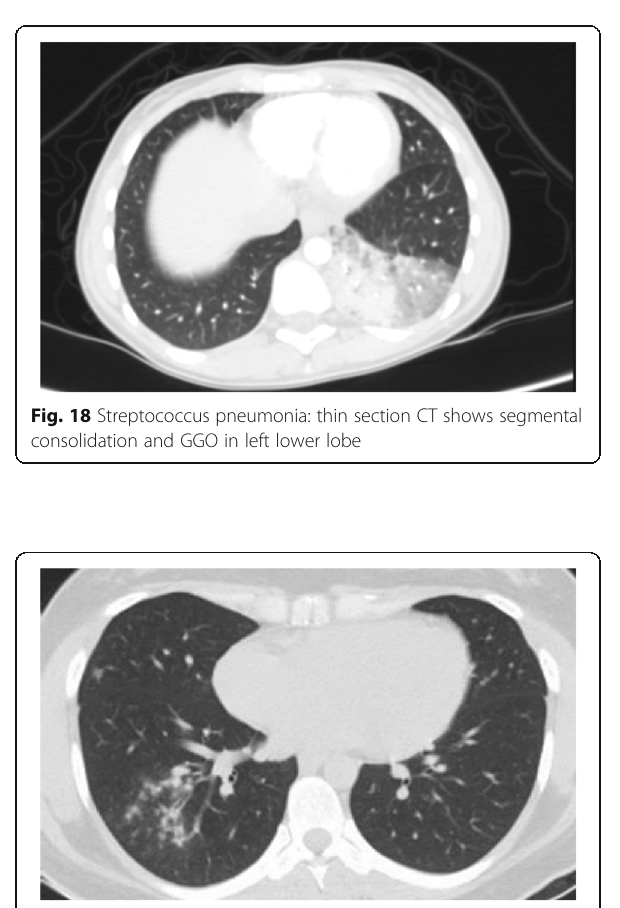
Fig. 19 COVID-19 pneumonia: thin section CT shows peribronchial thickening and centrilobular nodules with tree in bud appearance. despite atypical findings for COVID-19 pneumonia, RT-PCR test was positive for COVID-19